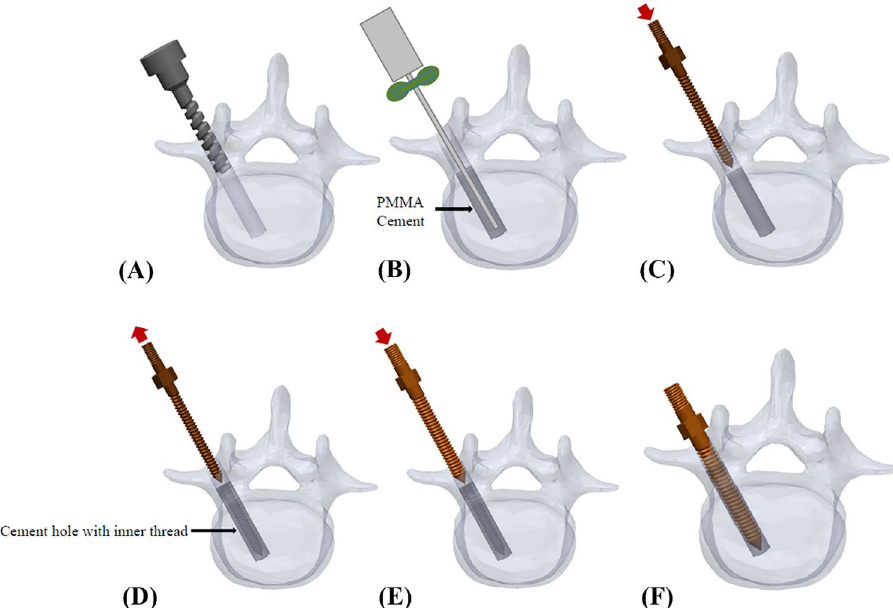
Figure 8. Schematic illustrations of the modified group. The 48 mm deep enlarged screw tract was formed by a 5.5 mm twist metric drill bit ( A ), and 0.8 ml PMMA was retrograde injected into the enlarged screw hole ( B ). A tapping screw was inserted into the PMMA- filled hole ( C ). After setting for 7 min, the screw was carefully removed, leaving a stiff threaded PMMA hole ( D ). A cylindrical or conical repair screw, sized according to that used in the traditional technique, was implanted ( D , E ). Vertebra with complete insertion of the repair screw ( F ).